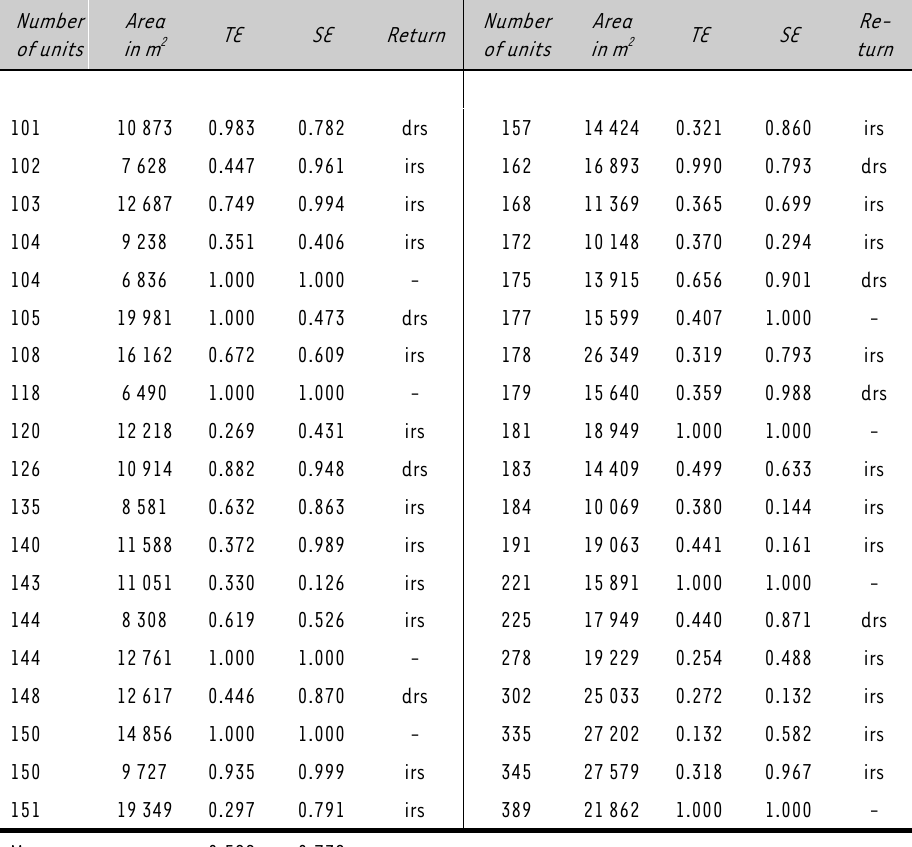
Relative efficiency estimates for large STDSs (n =